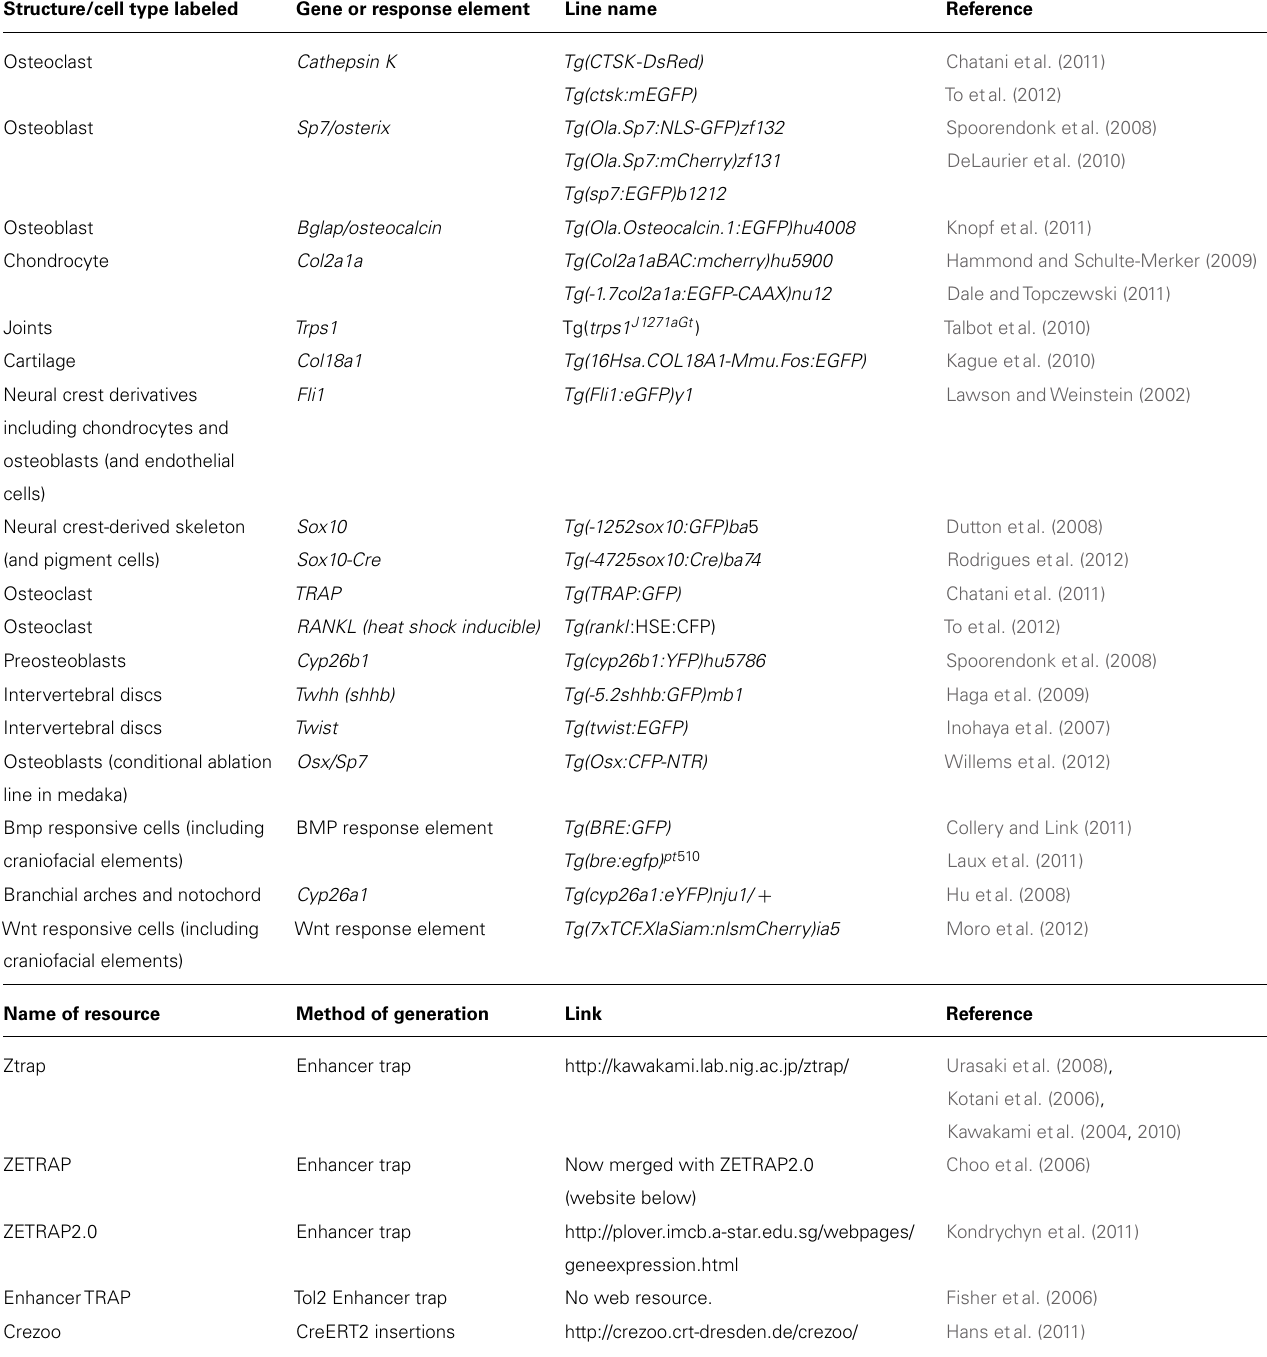
Table 1 |Table of existing transgenic lines and resources relevant to skeletal